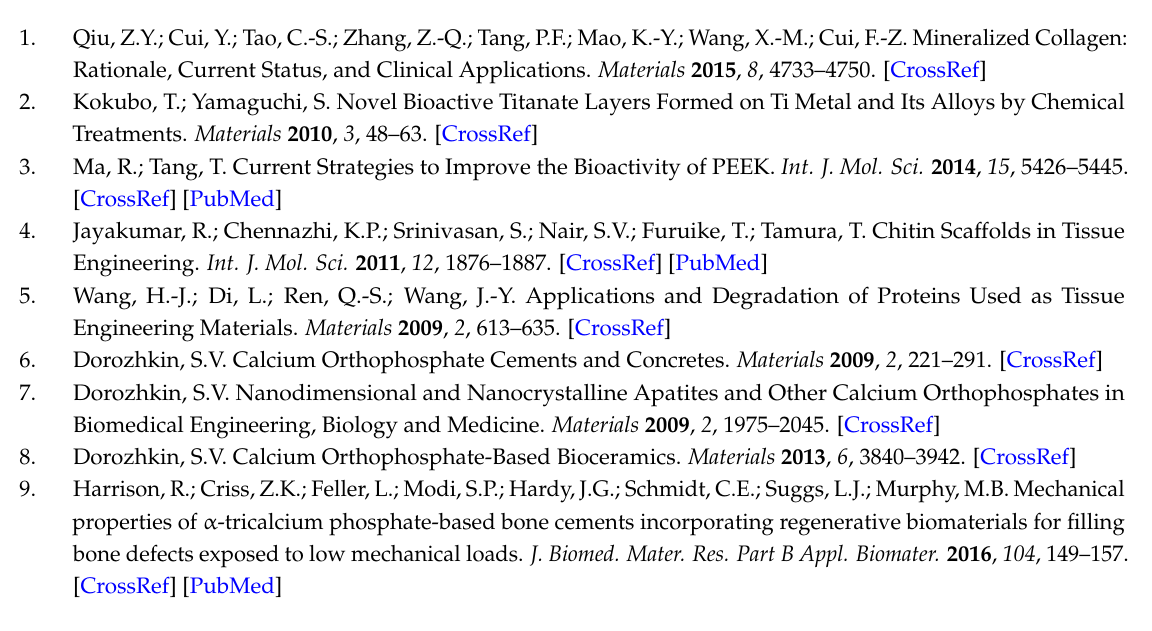
Figure S1: eADF-4(C16) films. Figure S2: PBT-25 films. Figure S3: PBT-50 films. Figure S4: PBT-75 films. Figure S5: PBT-100 films. Figure S6: PBTAT-25 films. Figure S7: PBTAT-50 films. Figure S8: PBTAT-75 films. Figure S9: PBTAT-100 films. Table S1: Positions of XRD peaks of films determined using Jade 9 XRD Pattern Processing software. Figure S10: FTIR spectrum of pure HFIP. Figure S11: Bright field microscope image of fibroblasts cultured on Nunclon ® Tissue Culture Plate (scale bar represents 100 µ